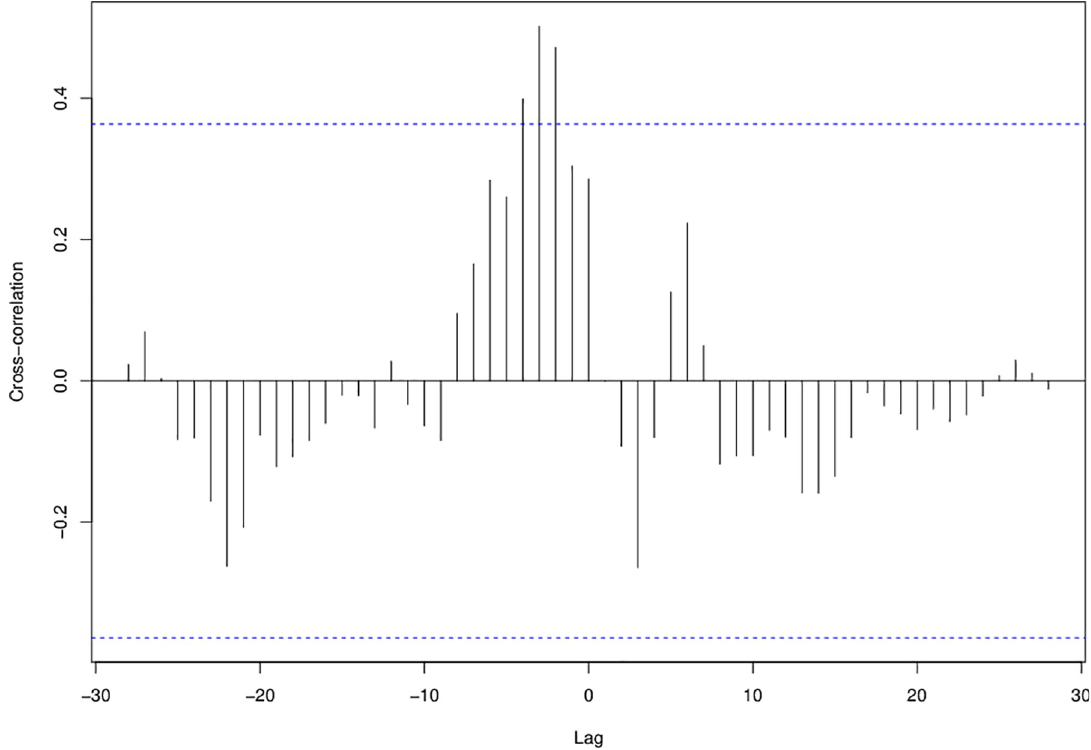
Fig 2. Cross correlation function between logged values of weekly transfers and COVID-19 positive cases. A positive correlation at lag -3 to -5 indicates that log transfers are positively associated with log COVID-19 cases 3-to-5 weeks later.